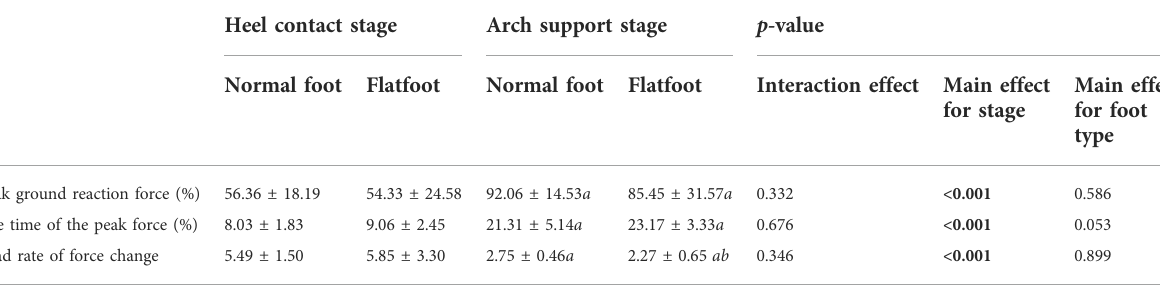
TABLE 2 Basic mechanical characteristics of plantar impact of different foot